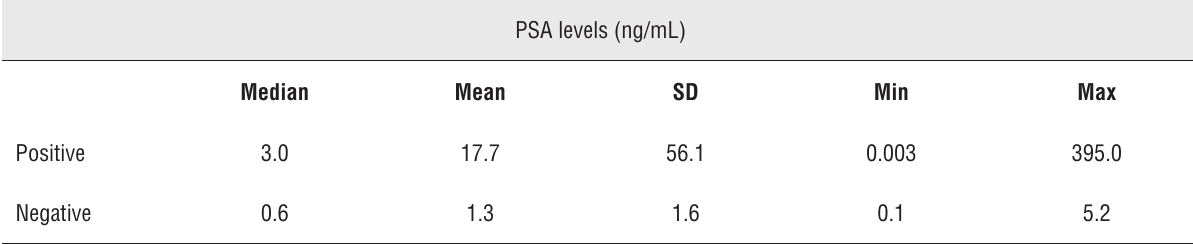
Table 4 - Serum pSA levels obtained immediately prior to 68 Ga-pSMA pET/cT results.